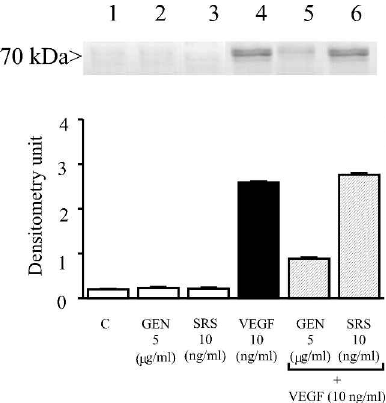
FIG. 5. The effects of genistein (GEN) and staurosporine (SRS) on COX-2 expressed in VEGF-treated HUVEC. COX-2 was detected by Western blots using specific antibodies to COX-2 in cell extracts of HUVEC treated with no addition (lane 1), with genistein (5 m g/ml) alone (lane 2), with staur- osporine (10ng/ml) alone (lane 3), with VEGF (10ng/ml) alone (lane 4), with VEGF (10ng/ml) + genistein (5 m g/ml; lane 5) or with VEGF (10ng/ml) + staurosporine (10ng/ml; lane 6) for 24h. Equal amounts of protein (20 m g/lane) were loaded in each lane. Similar results were obtained with cell extracts from three separate batches of cells. The significant differ- ences between each band were compared by scanner densitometry using an image one-dimensional program (densitometry unit).